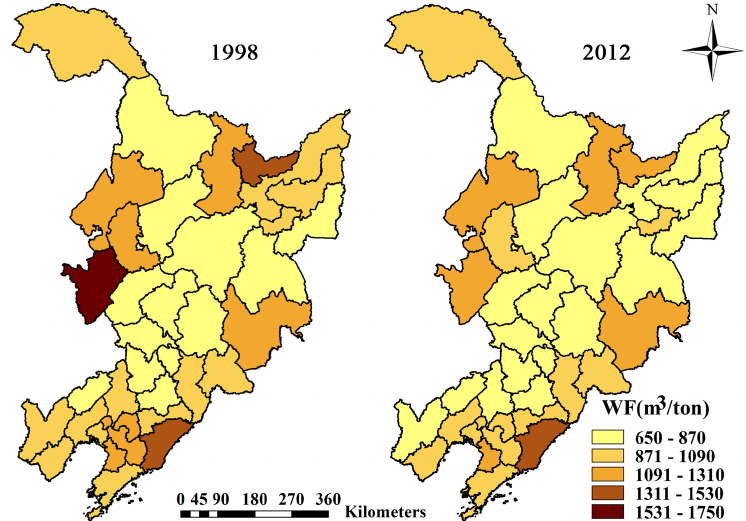
Figure 4. Spatial distribution of WF of maize production in 1998 and